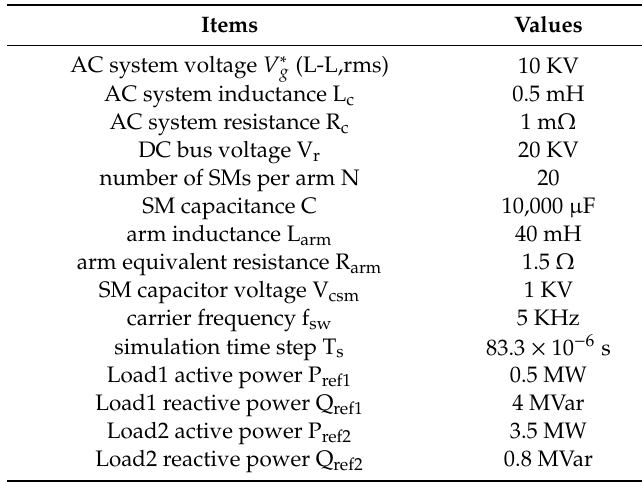
Table 1. MMC parameters and operational conditions applied to